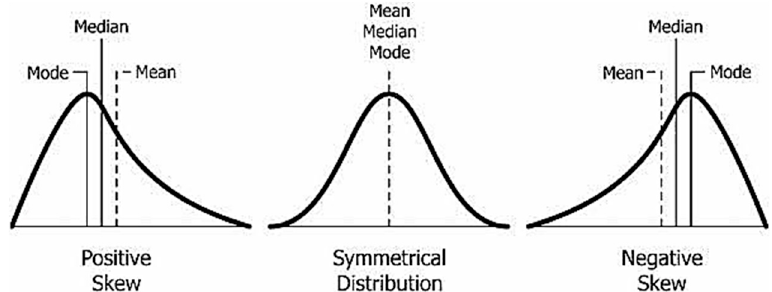
Figure 6. The PPG waves were categorized into three categories: G1 contains beats with clear systolic and diastolic waveforms with dicrotic notches; G2 contains beats without clear systolic and diastolic waveforms and without dicrotic notches; and G3 contains noisy waveforms.